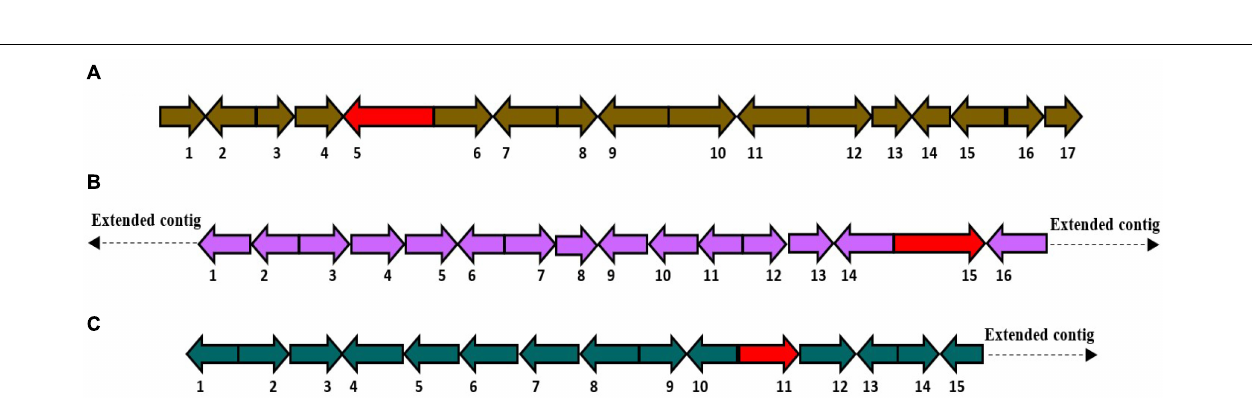
FIGURE 6 | (A) Schematic of putative HfasPKS-221 (74 Kb) biosynthetic gene cluster. 1 = Triphosphate hydrolase; 2 = Multidrug resistance; 3 = Hypothetical protein; 4 = Alpha-beta hydrolase; 5 = PKS1; 6 = Zinc finger H2C2; 7 = Kinesin-like protein; 8 = Hypothetical protein; 9 = Actin binding protein; 10 = DNA binding protein; 11 = Acetylcholinesterase; 12 = Actin depolymerizing factor; 13 = Metalloproteases; 14 = Metalloproteases; 15 = Metalloproteases; 16 = N -acetylglucosaminyltransferase; 17 = Transcription factor. (B) Schematic of putative HfasNRPS-29 (76 Kb) biosynthetic gene cluster. 1 = mRNA-decapping enzyme; 2 = Peptidase aspartic; 3 = Glycoside hydrolase; 4 = Polyadenylate binding protein; 5 = Mitochondrial carrier protein; 6 = Ubiquitin protease; 7 = Acid phosphatase; 8 = AMP-dependent synthetase and ligase; 9 = Exocyst complex; 10 = DUF domain protein; 11 = Carbohydrate transporter; 12 = Adenine DNA glycosylase; 13 = Cargo transport protein; 14 = WD repeat-containing nucleolar rRNA; 15 = Oxidoreductase; 16 = NRPS; 17 = Acyl-CoA N -acyltransferase. A homologous biosynthetic gene cluster was found in scaffold 100 of the Hypholoma sublateritium genome. (C) Schematic of putative HfasSidA-14 (98 Kb) biosynthetic gene cluster. 1 = Transcription factor; 2 = Sterol desaturase; 3 = Cytochrome P450; 4 = Triphosphate hydrolase; 5 = Calcium transporting; 6 = Glycosyltransferase; 7 = GMC oxidoreductase; 8 = Amino acid transporter; 9 = Zinc binding protein; 10 = ABC transporter; 11 = Sid A; 12 = Glycoside hydrolase; 13 = Transporter; 14 = RNA-associated protein; 15 =